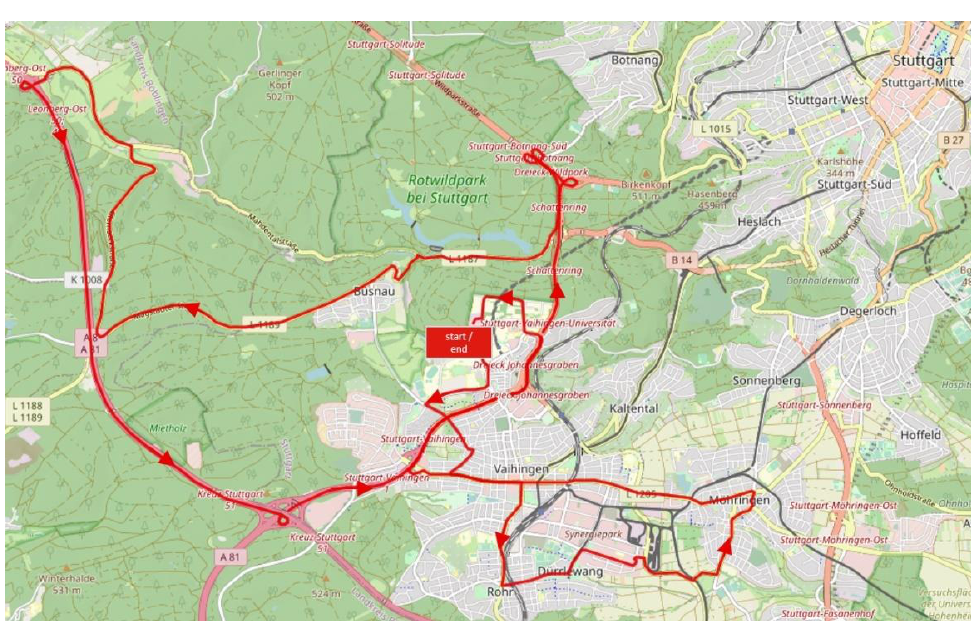
Figure A3. Map of the real driving cycle. Plotted with data from OpenStreetMap.org, accessed on 12 November 2022. Table A2. Real driving cycle in and around Stuttgart.